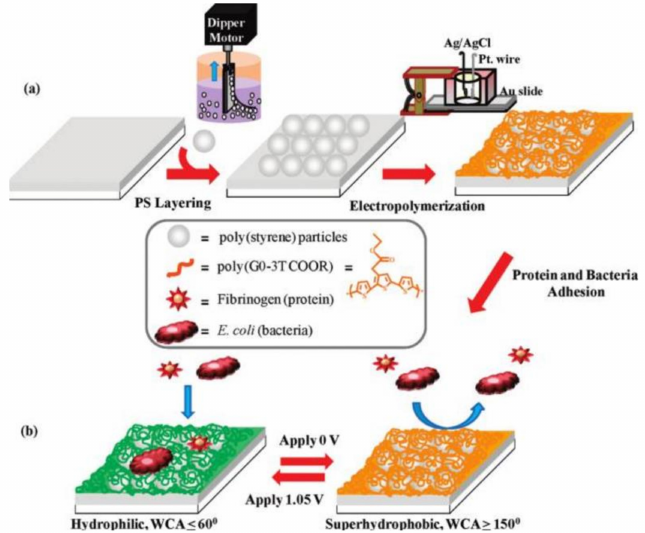
Figure 8. ( a ) Fabrication scheme of the superhydrophobic polymeric surface. ( b ) Protein and bacterial adhesion onto the undoped (orange-colored film) and doped (green-colored film) polythiophene surfaces. Copyright (2012) American Chemical Society